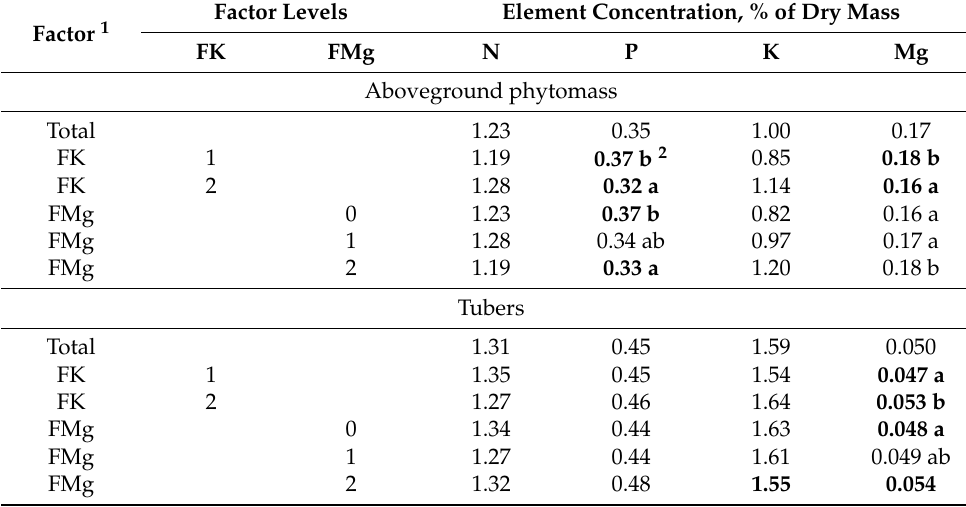
Table 6. Total N, P, K and Mg concentrations in aboveground potato phytomass and tubers produced in the last year of the microplot field experiment with potassium (FK) and magnesium fertiliza- tion (FMg).